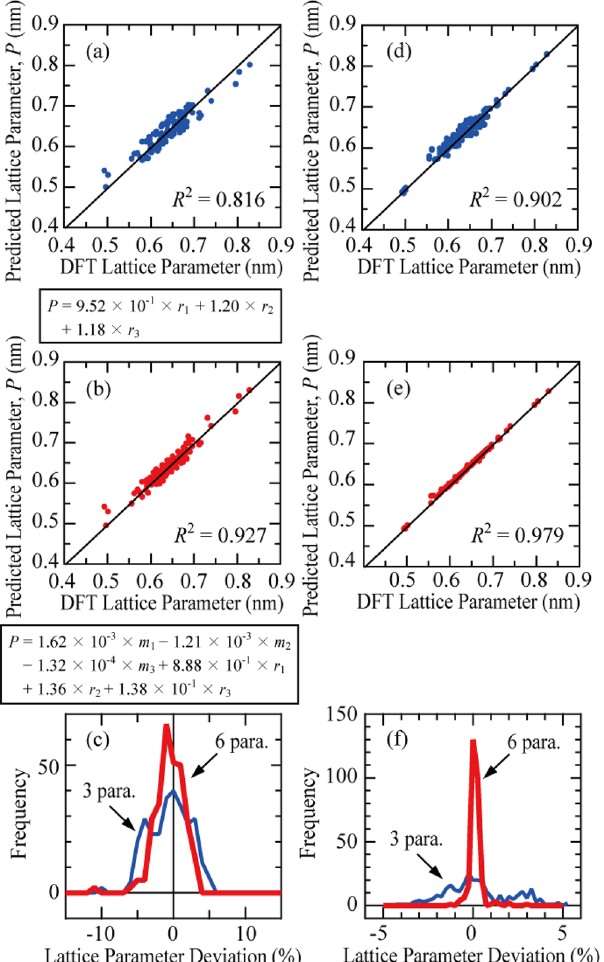
Figure 2. Comparison between the lattice parameters predicted by DFT calculations and those predicted by: ( a – c ) the ML model of multiple linear regression and ( d – f ) the ML model of boosted decision tree regression. ( a , d ) and ( b , e ) are the results of ML using a combination of atomic radii (3 parameters) and atomic mass and atomic radius (6 parameters) as descriptors, respectively. The regression equations determined by multiple linear regression are shown at the bottom of figures ( a , b ). ( c , f ) Frequency of deviations between the calculated and predicted lattice